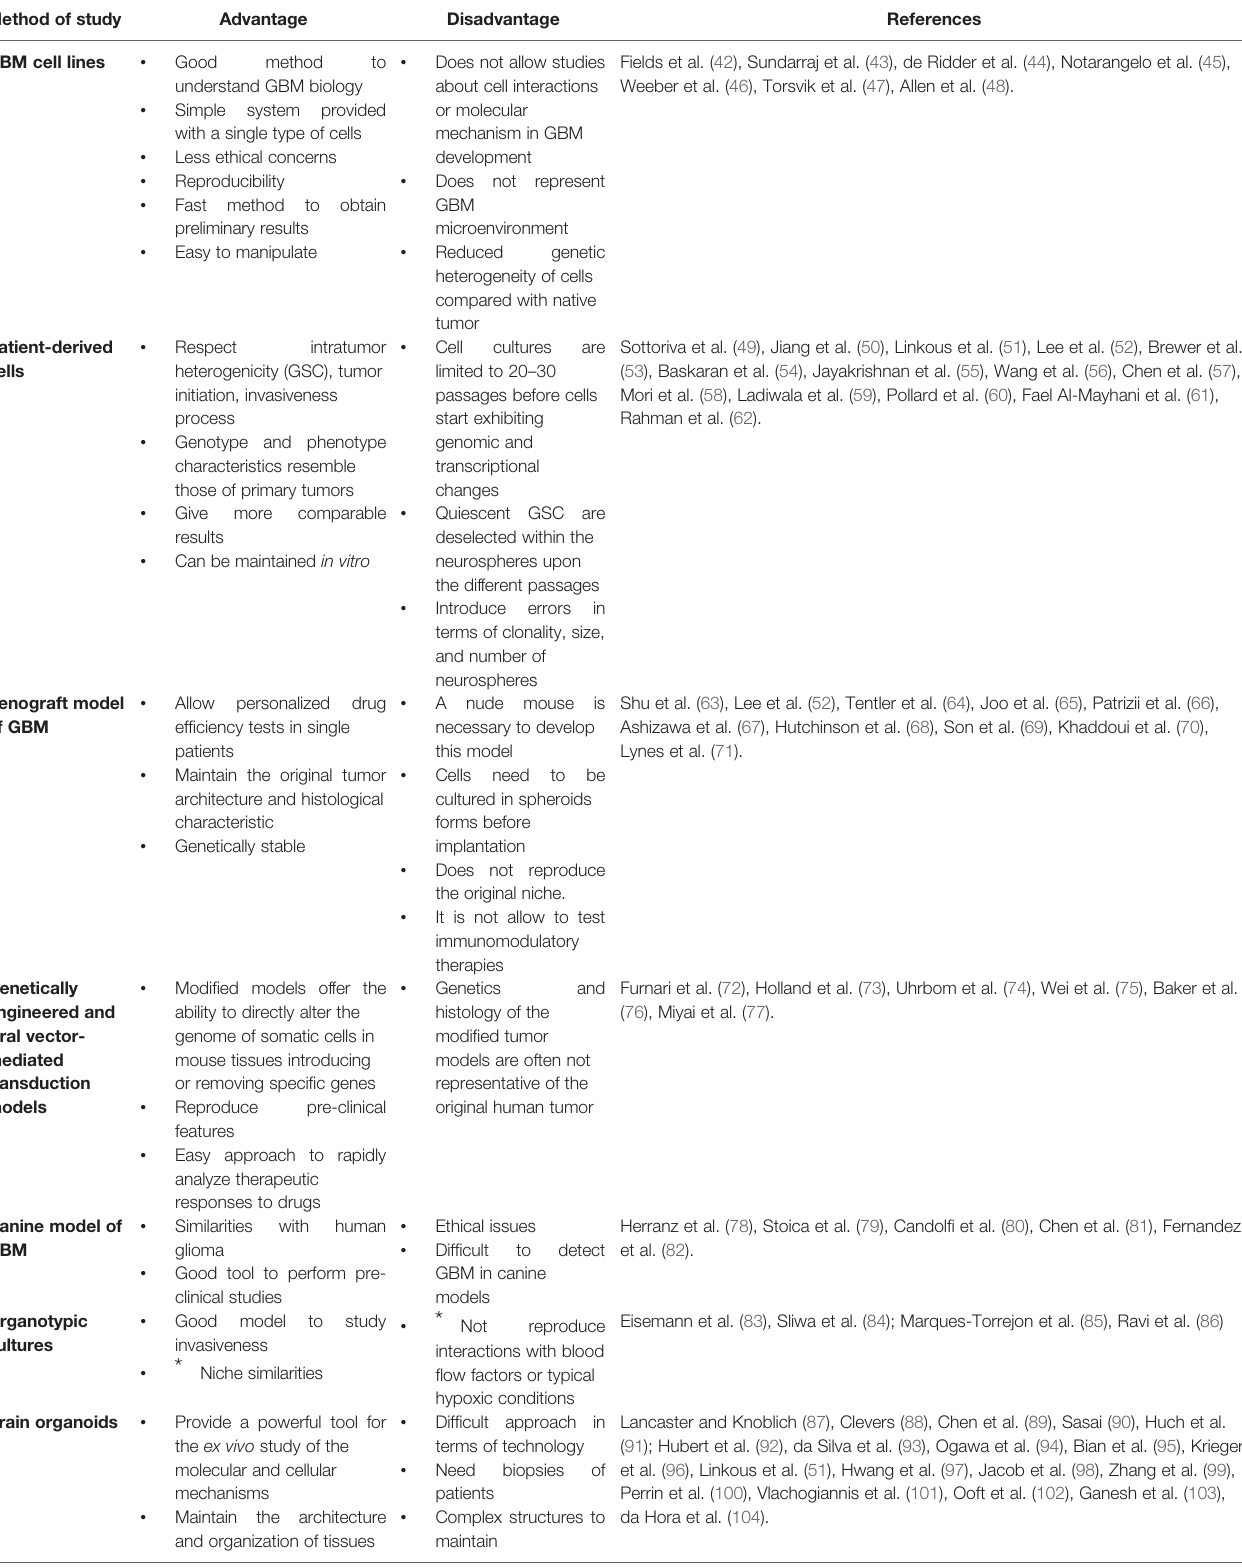
TABLE 1 | Advantages and disadvantages of GBM experimental models. Method of study Advantage Disadvantage GBM cell